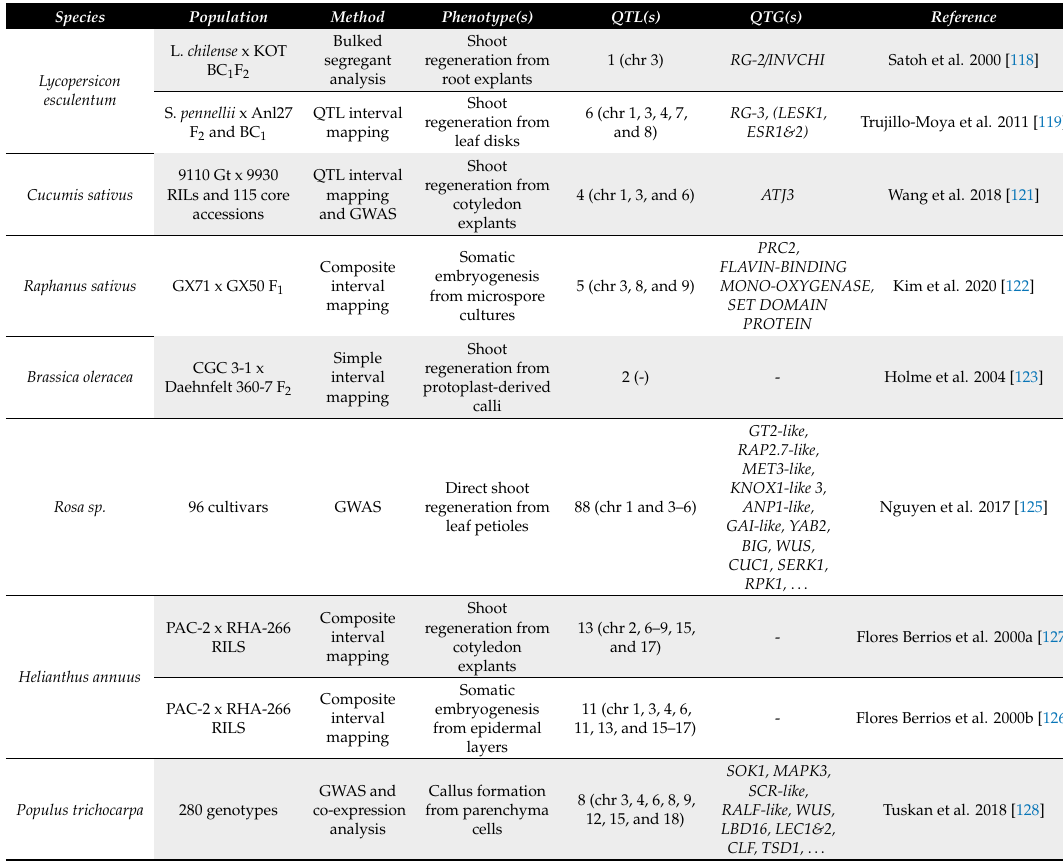
Table 3. Nonexhaustive overview of QTL mapping studies on regeneration in dicot crops since 2000. The QTL and QTG columns respectively specify the number (and chromosomal position) of quantitative trait loci and highlight quantitative trait genes (plausible candidates are